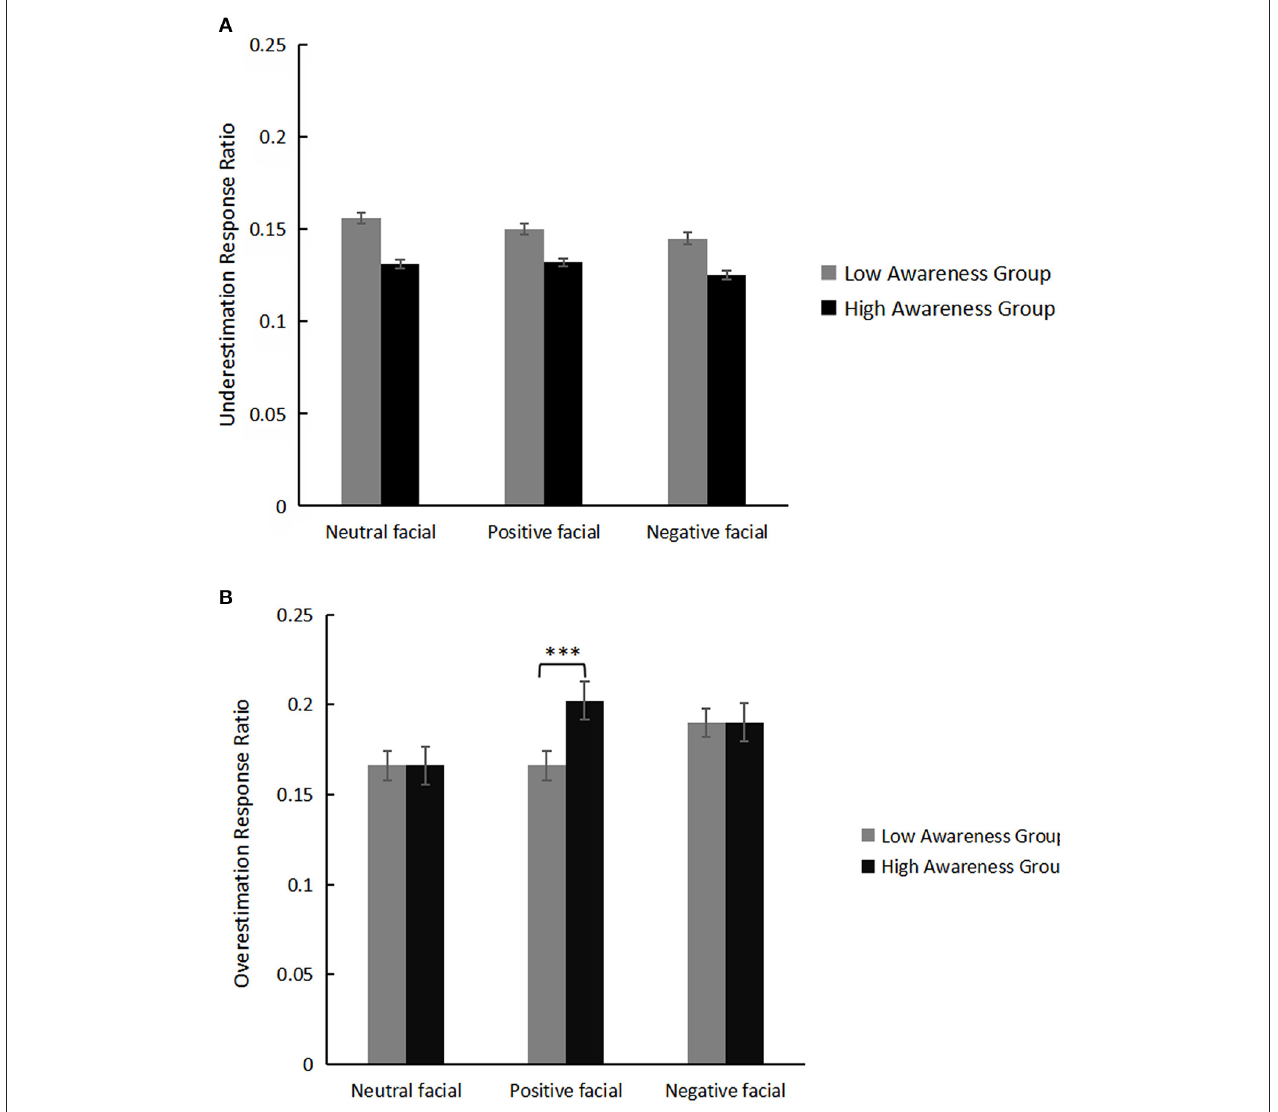
FIGURE 2 | Means and standard error of underestimation response ration (A) and overestimation response ratio (B) for the high and low awareness groups. “***” represents the p <